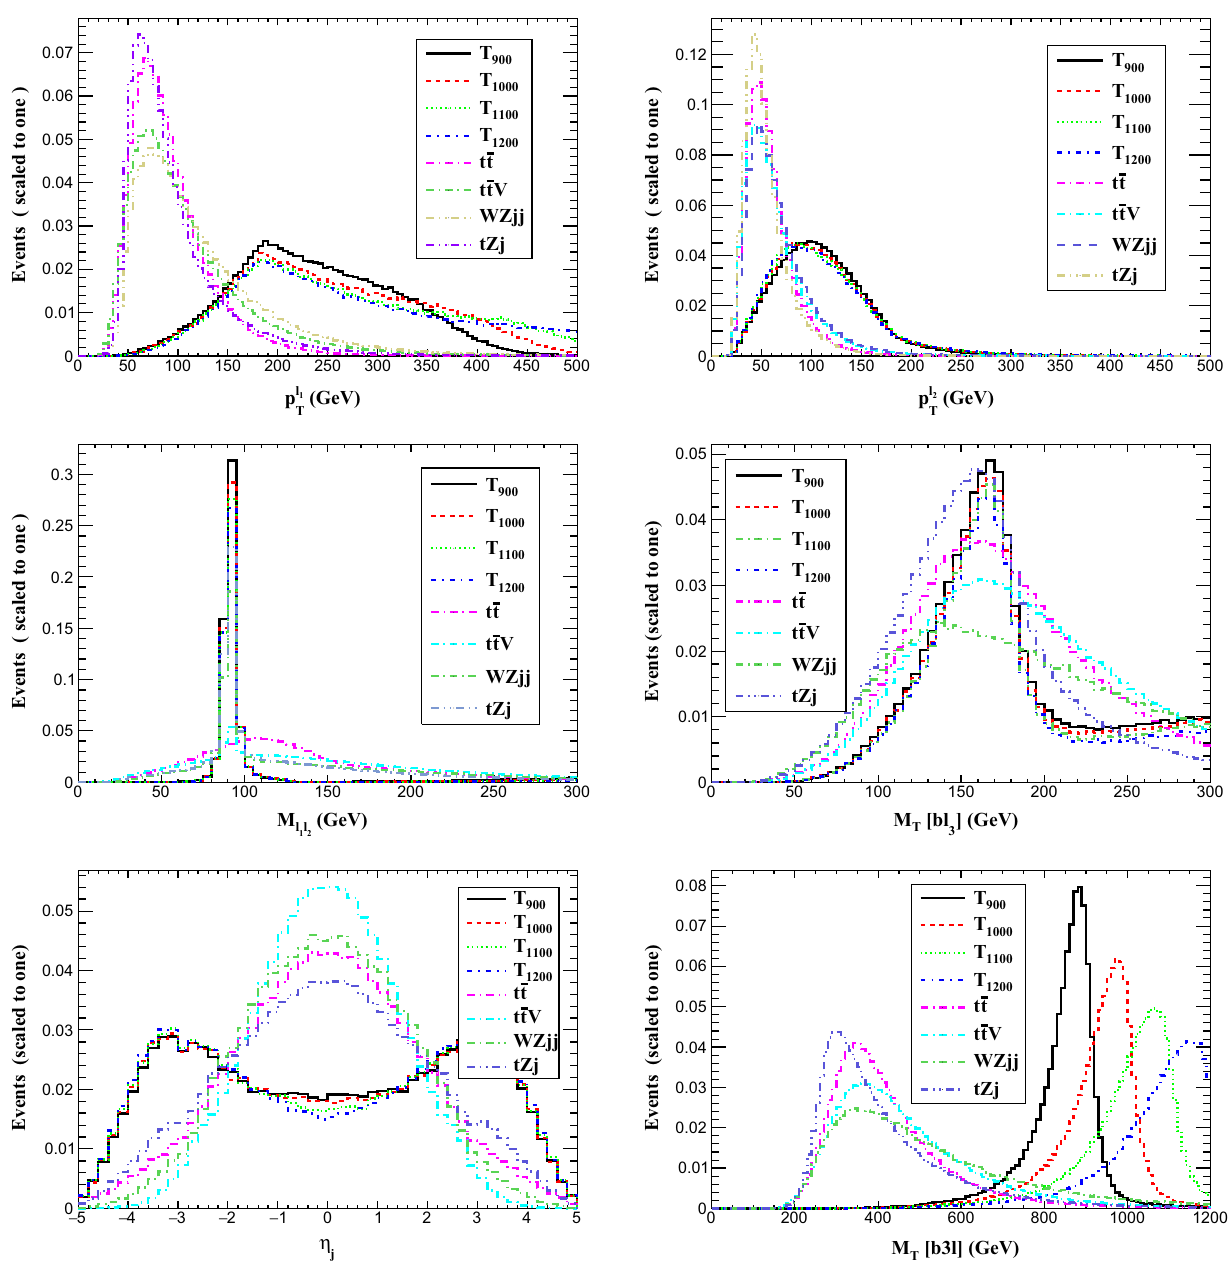
Fig. 8 Normalized distributions for the signals and backgrounds